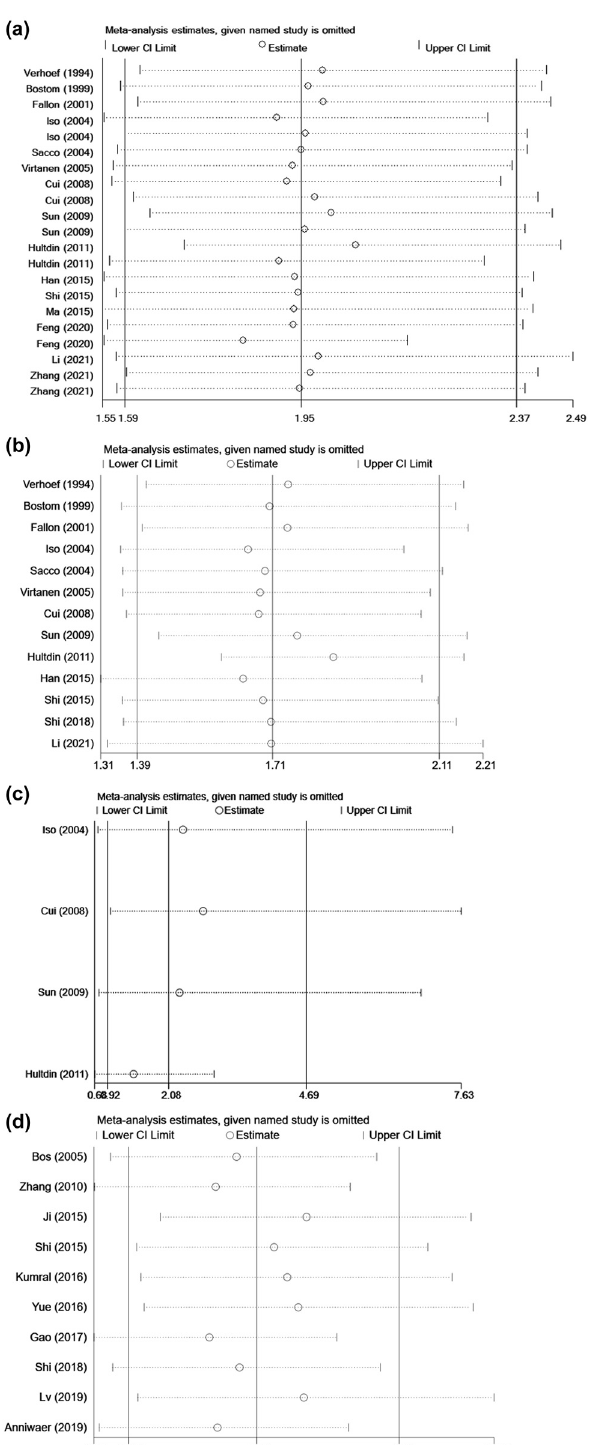
Figure 6: Sensitivity analysis of the relationship between Hcy levels and strokes. The deletion of any of the included studies had no signi fi cant e ff ect on the combination of the remaining works and OR, con fi rming the stability of the fi nal results of the current research: ( a ) strokes; ( b ) ischemic strokes, ( c ) hemorrhagic strokes, and ( d ) recurrent strokes.